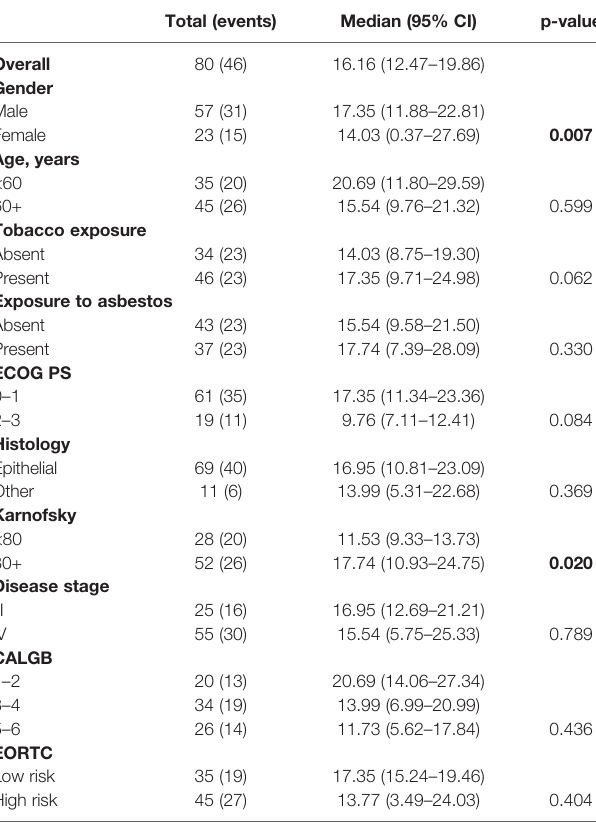
TABLE 2 | Univariate analysis for association with progression-free survival to cisplatin/gemcitabine treatment.